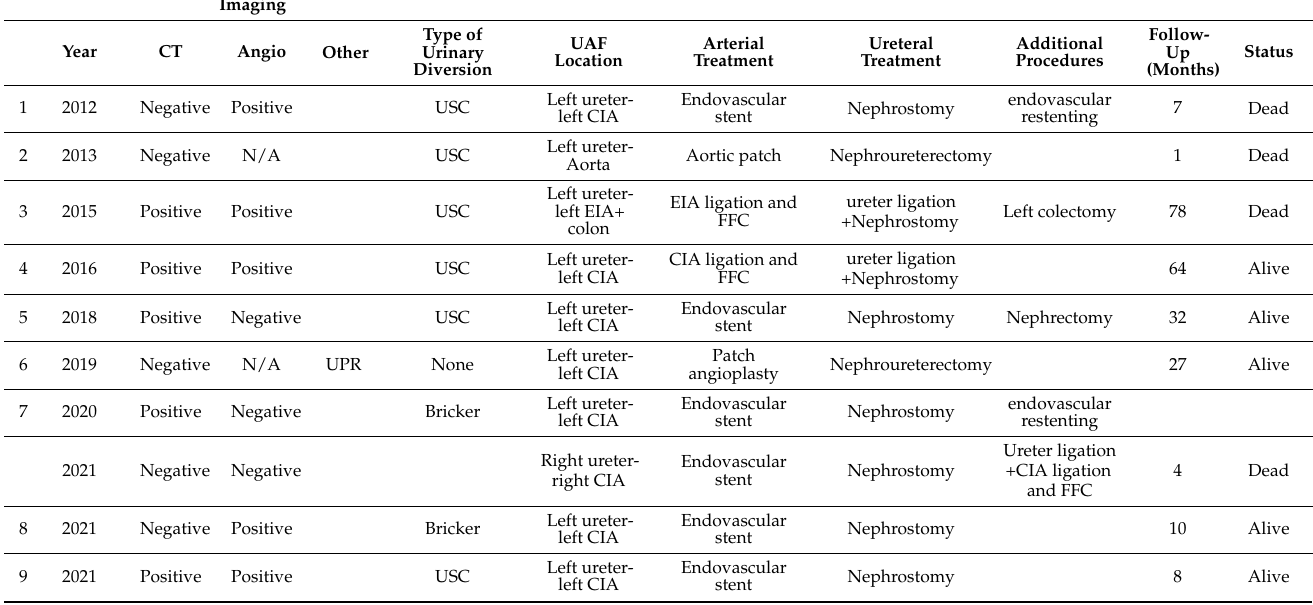
Table 3. Pretreatment diagnostic imaging, treatment options and outcomes of patients in our cohort (CT—computed tomography; Angio—Angiography; CIA—common iliac artery; FFC—femorofemoral crossover